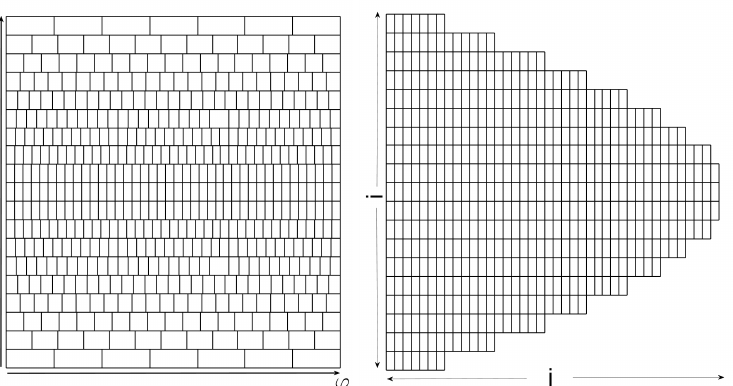
Figure 16. Two illustrations of the accumulator array M with almost-equal-sized cell quantization. Left: The accumulators tessellating the θ − ϕ plane. Right: Accumulators represented by identical rectangles, where the i axis represents the nearest integer multiple of ∆ θ and the j axis represents the nearest integer multiple of ∆ ϕ